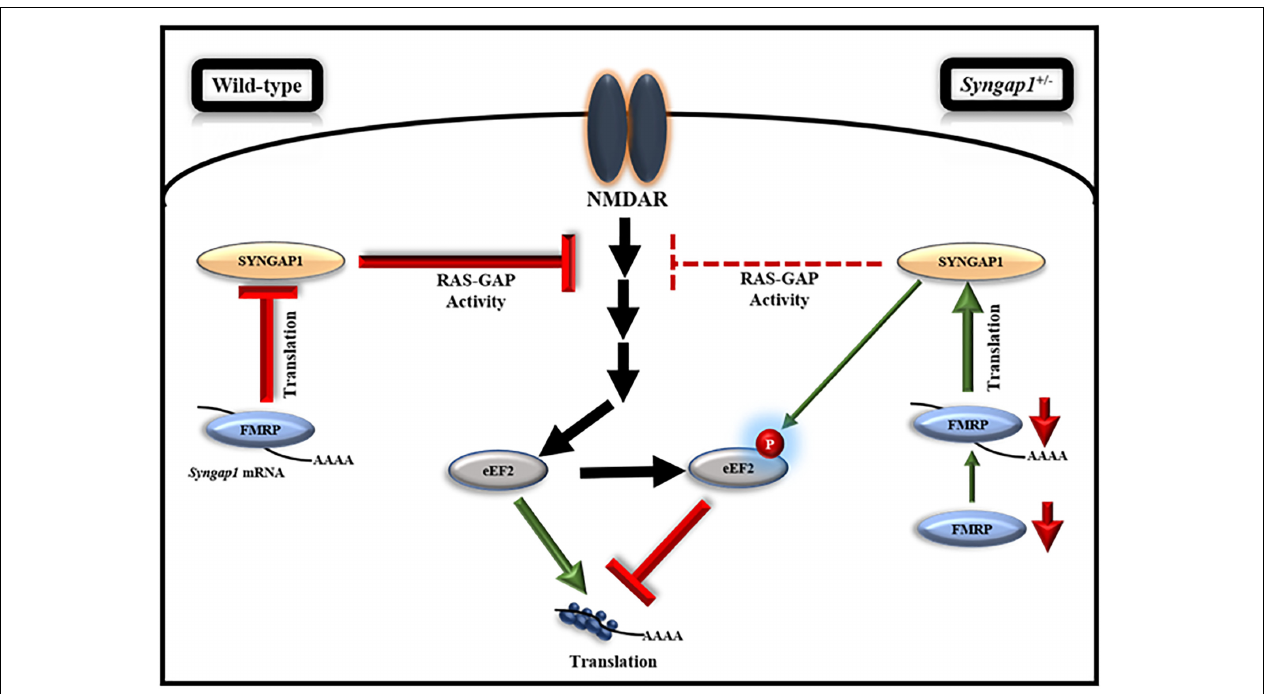
FIGURE 5 | Model, illustrating the regulation of FMRP-mediated translation of Syngap1 during development. This model shows that FMRP regulates Syngap1 mRNA translation, which in turn regulates NMDAR-mediated signaling. In WT, NMDAR stimulation in synapse led to increased phosphorylation of eEF2, which resulted in global translation inhibition and the signaling was efficiently regulated by SYNGAP1. Whereas, in Syngap1 − / + at PND14-16, NMDAR-mediated signaling was impaired as depicted by the loss of phosphorylation response to eEF2 due to a decreased level of SYNGAP1. At PND21-23 in Syngap1 − / + , FMRP level was low that increased translation of Syngap1 mRNA leading to an increased SYNGAP1 level compared to PND14-16. Thus, an elevated level of SYNGAP1 might recover the NMDAR-mediated signaling via phosphorylation of